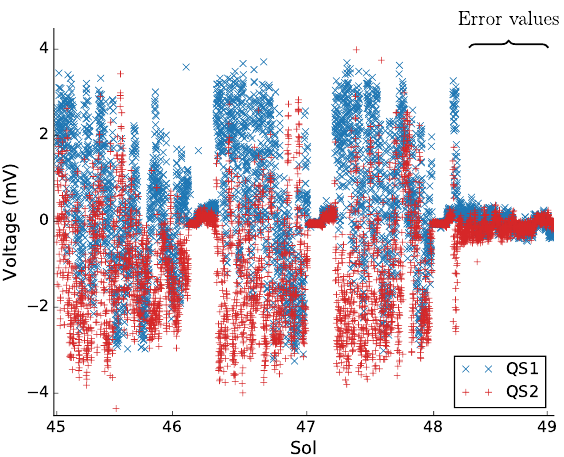
Figure 3. Failure of the heater element of VL1’s quadrant sensor during sol 46.